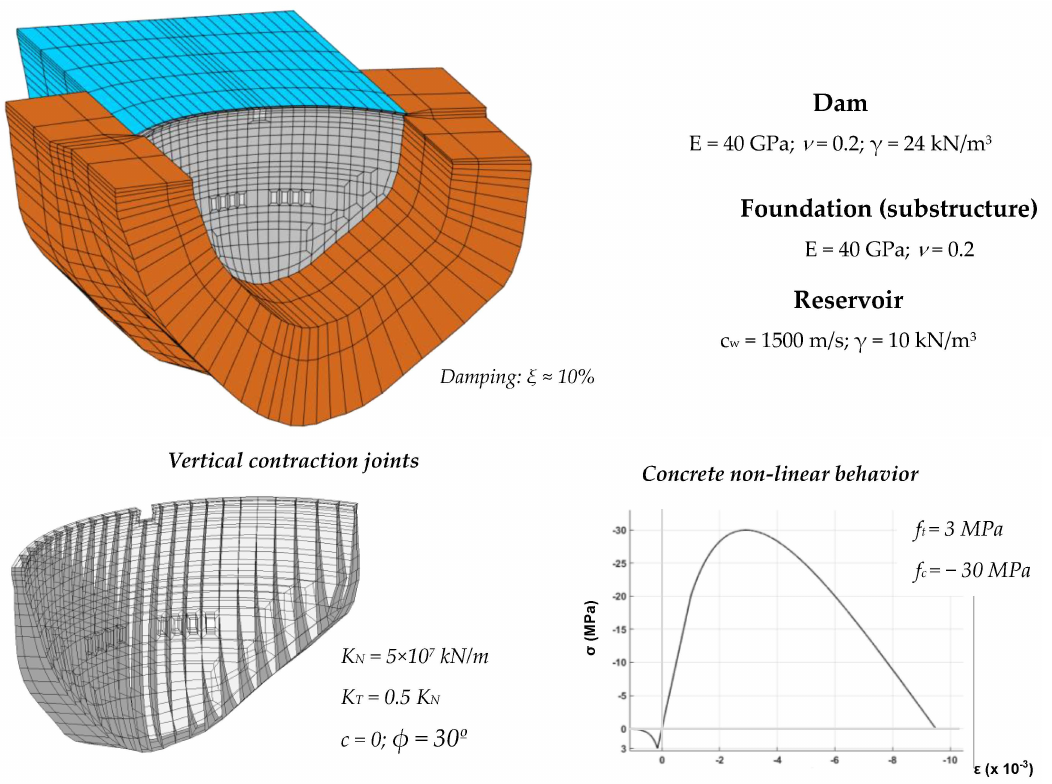
Figure 12. Finite element mesh and material properties used for dynamic analysis of Cahora Bassa